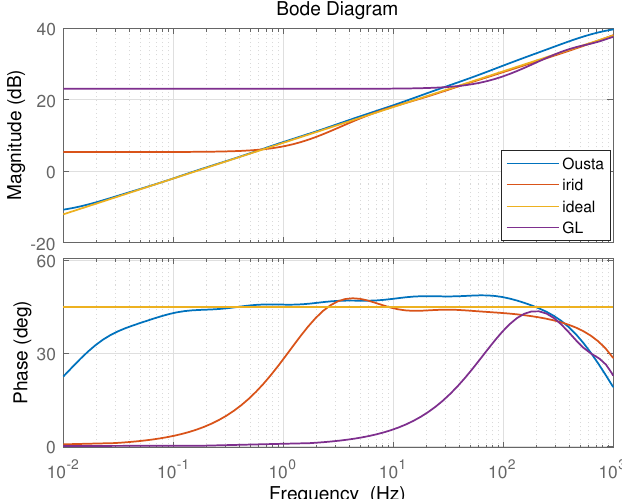
Figure 4. Case 1: 7th order discretization approximate Bode graph of s 0.5 in the frequency band [0.01, 1000] Hz.